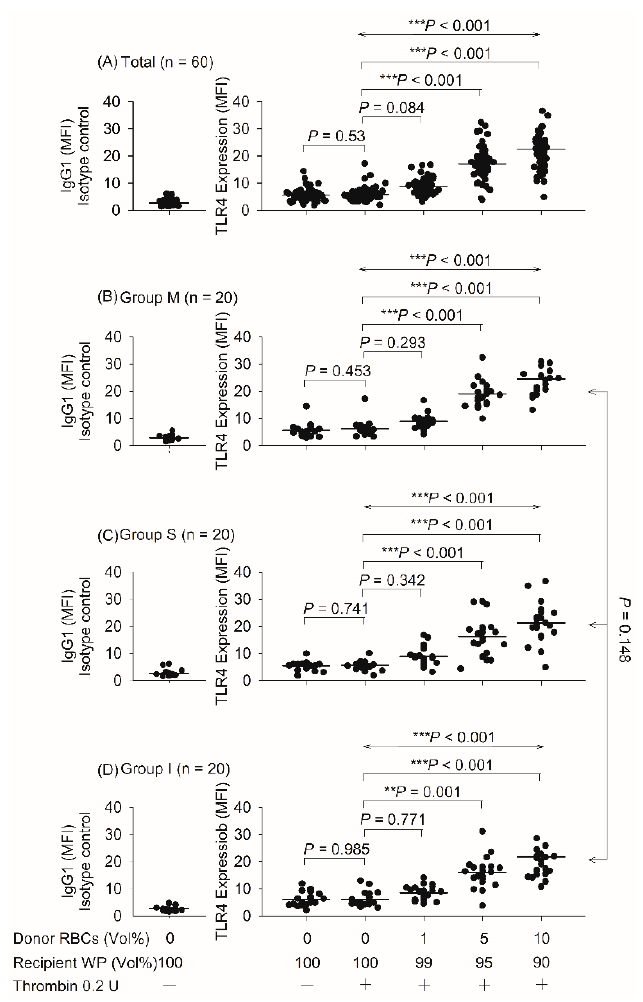
Figure 2. Effect of TLR4 expression on groups M, S, and I after the mixing of donor red blood cells and washed platelets. MFI, mean fluorescence intensity; RBCs, red blood cells; vol, volume; WP, washed platelets. Data are expressed as mean ± SD. ** p < 0.01, *** p < 0.001